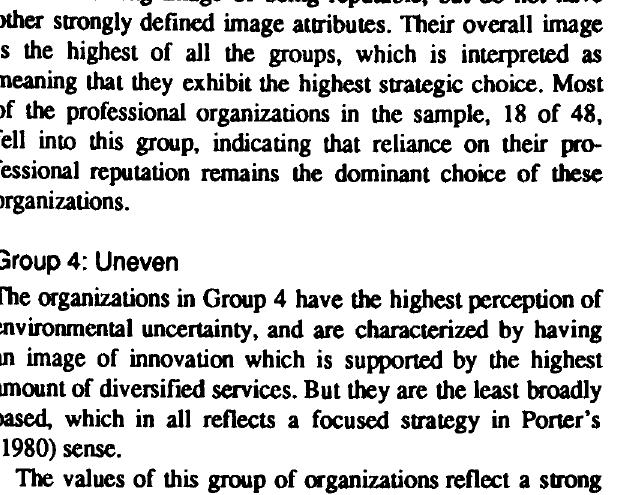
Figure 4 Five-group classification of professional service organi zations compared to the Hrebinialt & Joyce (1985) typology Group 2: